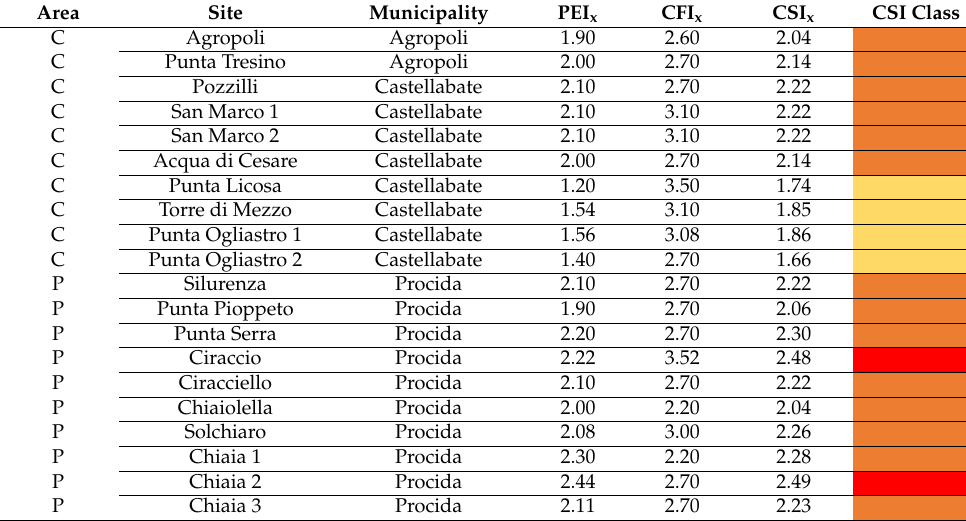
Table 6. Main characteristics of the study sectors in the Cilento (C) and Procida (P) areas, classified by sites, municipality, Physical Elements Index (PEI x ), Forcing Index (CFI x ), Susceptibility Index (CSI x ) and Susceptibility Class (CSI x Class). Colors according to Table